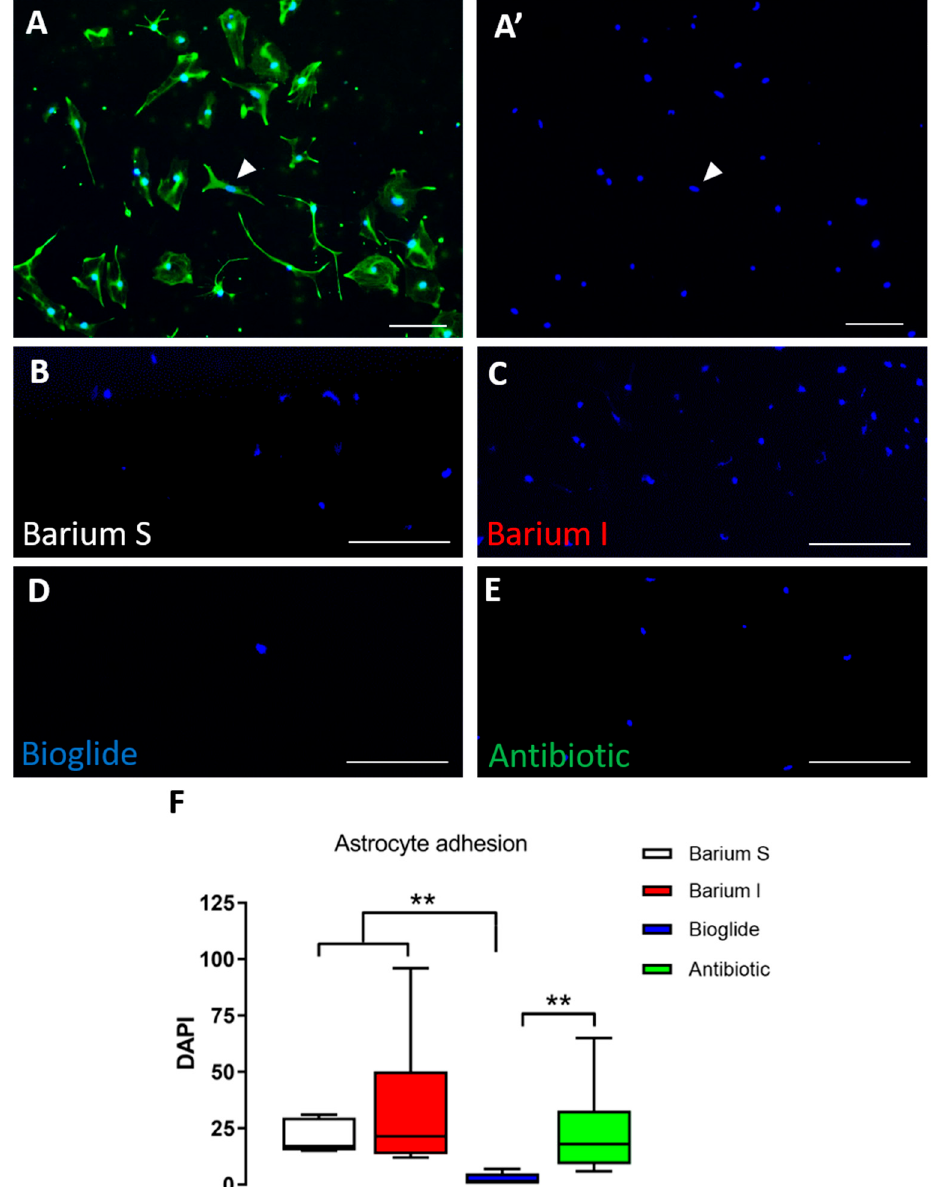
Figure 3. Astrocyte adhesion on the surfaces of commercial ventricular catheters. ( A , A’ ); Immuno- cytochemistry against GFAP, a specific astrocyte marker, and DAPI ( A ) to label nuclei (arrowhead). Cellular adhesion was quantified using DAPI ( A’ ). ( B ); Representative image of DAPI labeling after 24 h of cellular adhesion onto barium stripe catheters. ( C ); Representative image of DAPI after cellu- lar adhesion onto barium-impregnated catheters. ( D ); Representative image of DAPI after cellular adhesion onto bioglide catheters. ( E ); Representative image of DAPI after cellular adhesion onto antibiotic-impregnated catheters. ( F ); Graphical representation of cellular adhesion in the different catheter types, indicating significantly less adhesion in Bioglide catheters (** p < 0.01). Data included n = 6 values per condition and were analyzed with the nonparametric Mann–Whitney U-test. Barium S = barium stripe; Barium I = barium impregnated; Bioglide = polyvinylpyrrolidone; Antibiotic = antibiotic-impregnated. Scale bars: 100 µm .